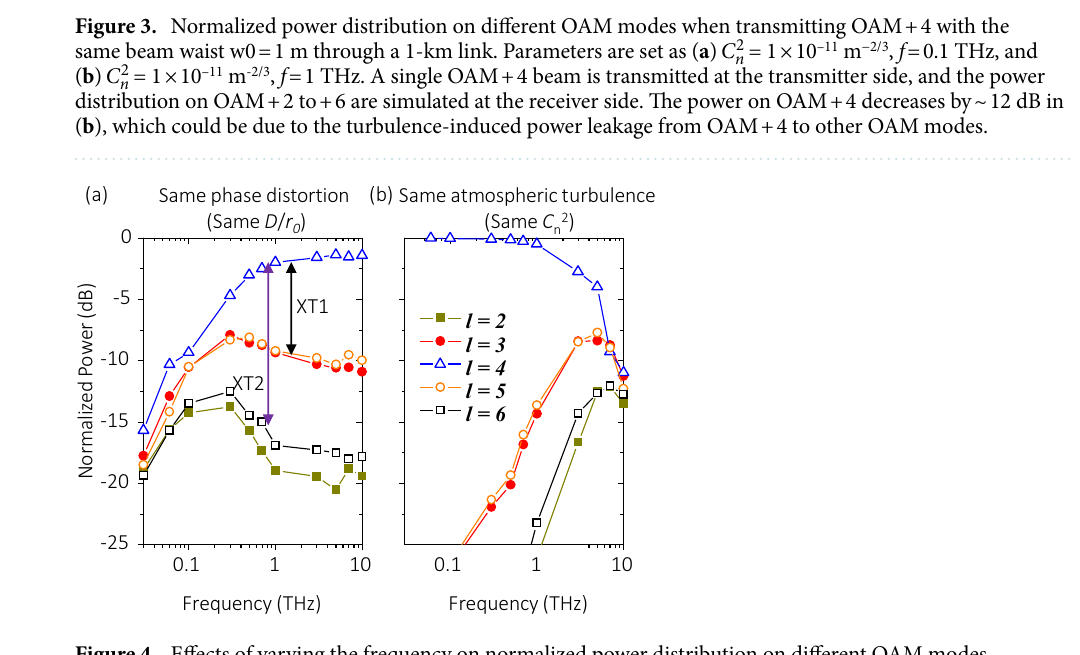
Figure 4. Effects of varying the frequency on normalized power distribution on different OAM modes. ( a ) 200-m link with D / r 0 = 0.224, w 0 = 0.1 m at the transmitter side, ( b ) 200-m link with C w 0 = 0.1 m. OAM + 4 is transmitted for all the cases. Legends and scales in y -axis in ( a , b ) are the